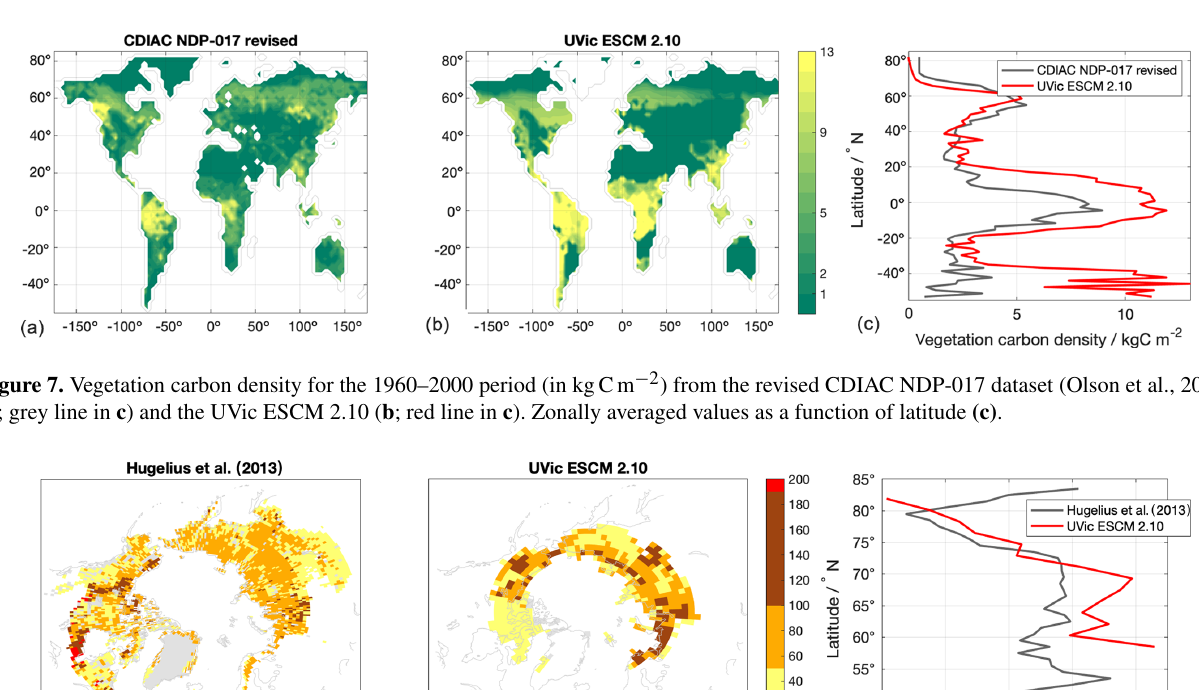
Figure 6. Air–sea carbon flux for the year 2005 (in molCm − 2 yr − 1 ) from the revised dataset from Takahashi et al. (2009) ( a ; grey line in c ) and the UVic ESCM 2.10 ( b ; red line in c ). Zonally averaged values as a function of latitude (c) .